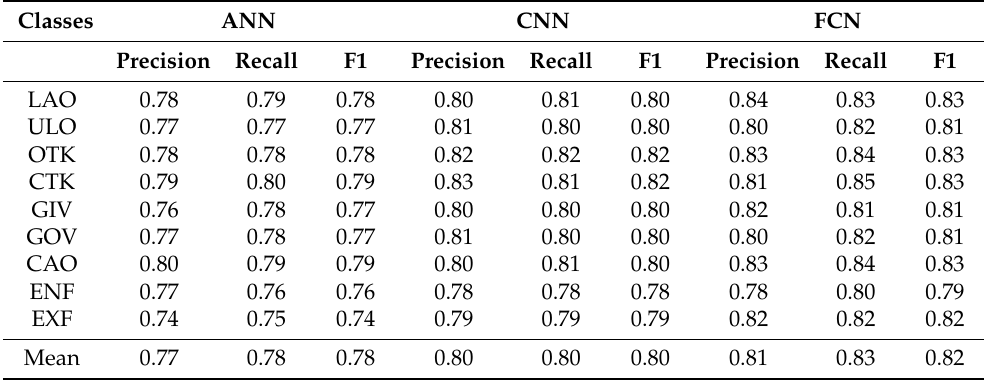
Table 7. Comparison with well-known classifiers in terms of precision, recall, and F1 measure over VIRAT Video dataset.